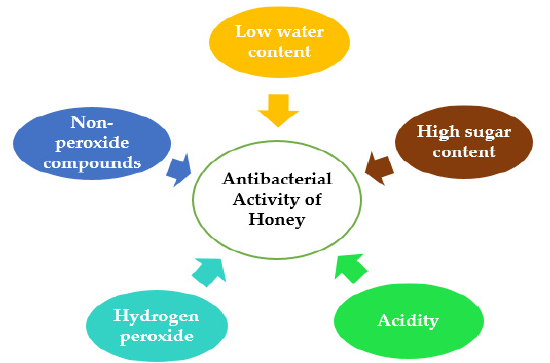
Figure 1. Schematic diagram presenting the parameters contribute to the antimicrobial activity of